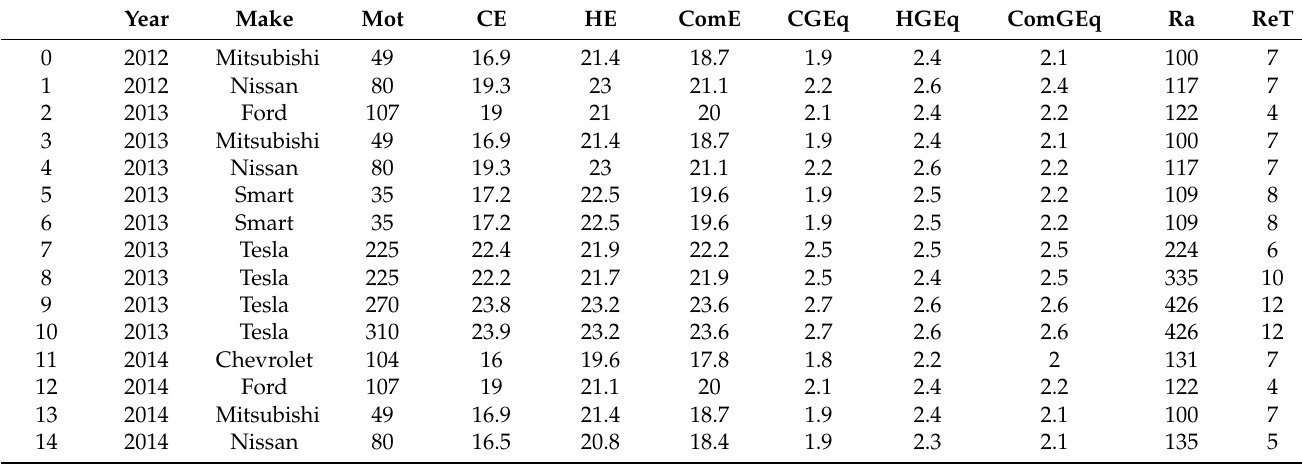
Table 1. Datasets for the